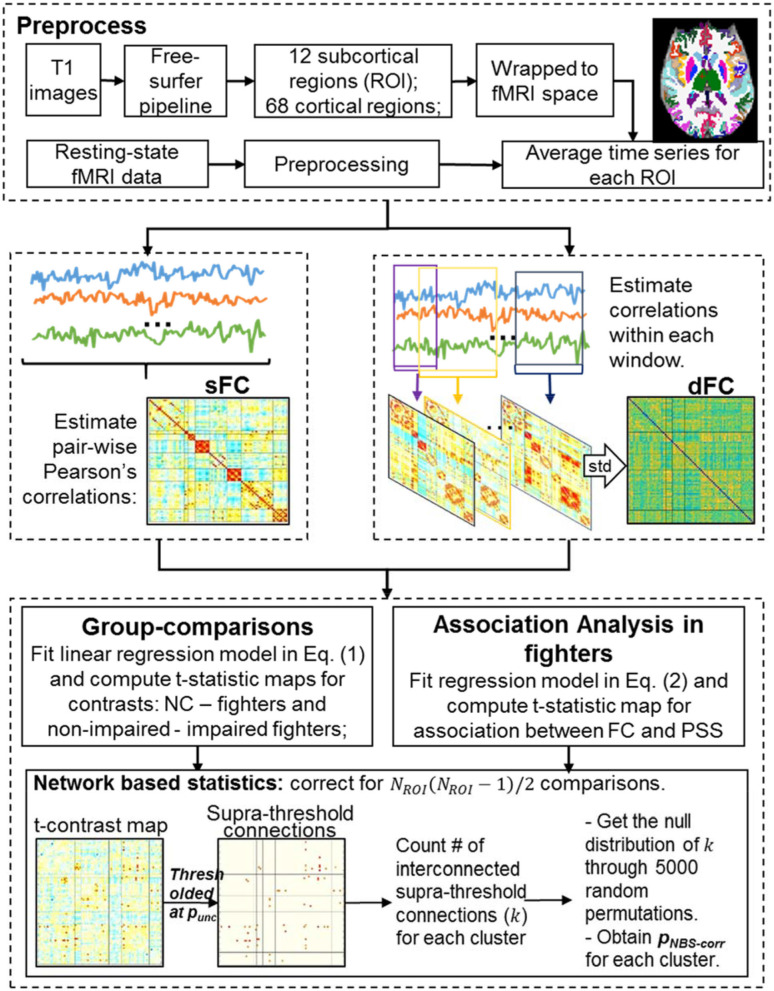
MRI data analysis.